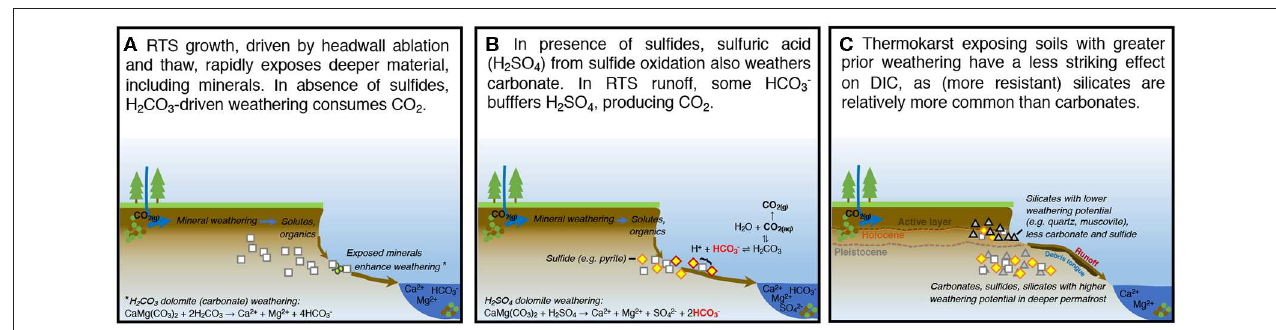
FIGURE 6 | Refined conceptual model of RTS effects on inorganic carbon cycling on the Peel Plateau (A) in the presence of carbonates and absence of sulfides and (B) in the presence of both carbonates and sulfides. (C) Depicts how this paper builds on previous understanding. Adapted from Zolkos et al. (2018).